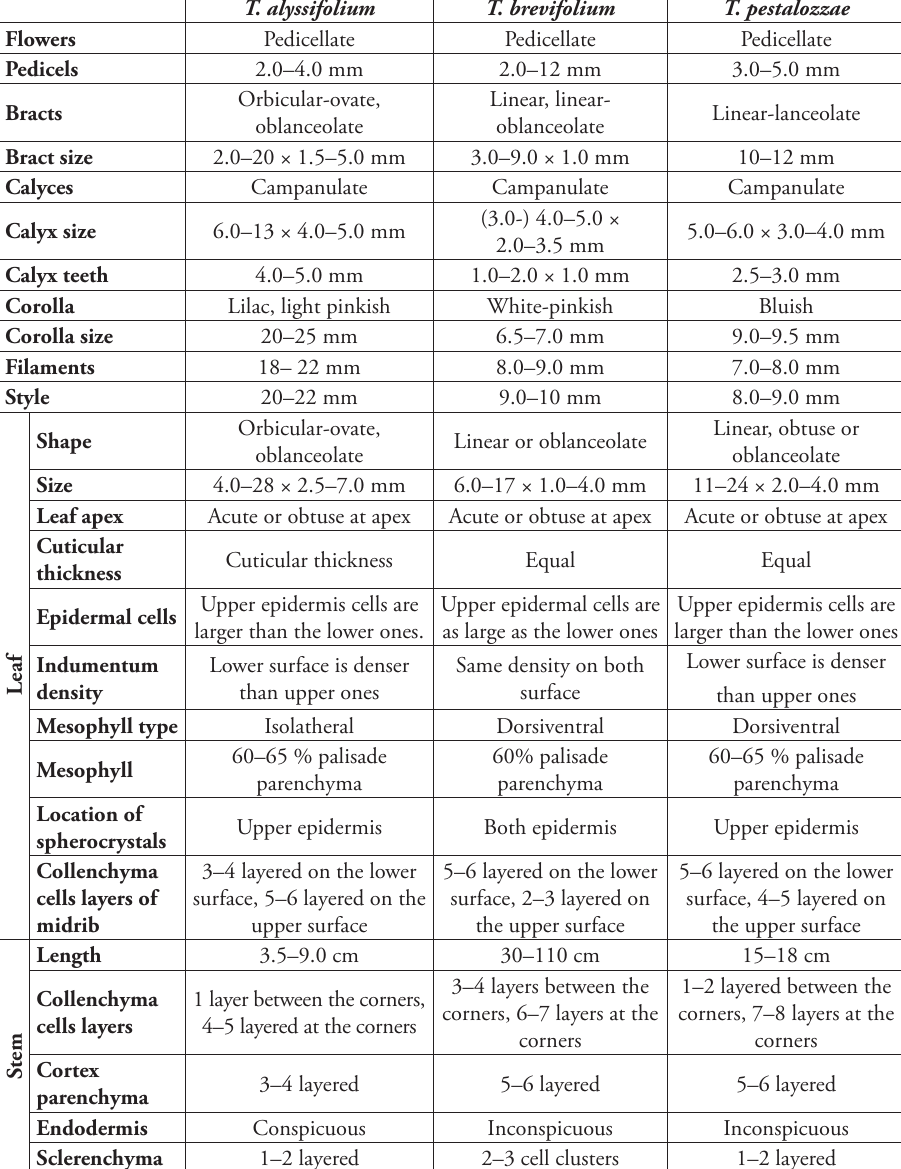
Table 2. Morphological and anatomical comparison of studied